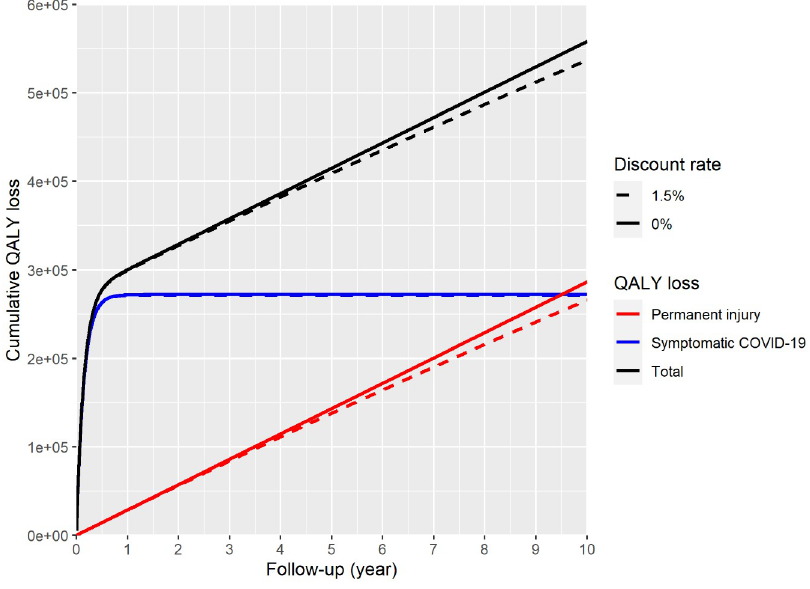
Fig 3. Cumulative QALY loss for symptomatic COVID and permanent injury due to